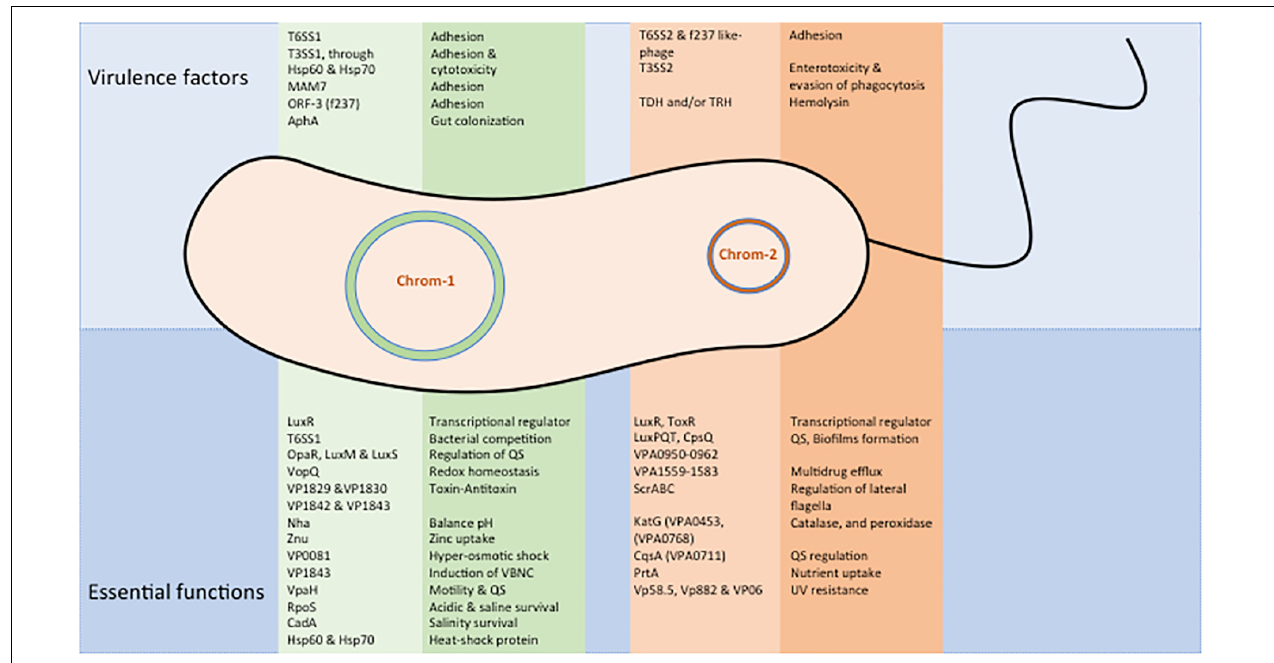
FIGURE 2 | Major virulence and essential functional proteins of V. parahaemolyticus. Expressed gene functions are shown separately for chromosome-1 and